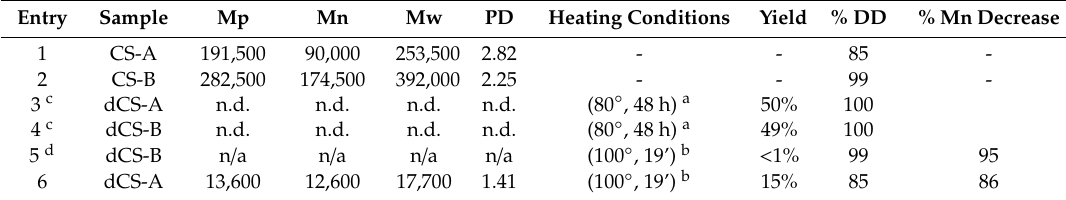
Table 1. Comparison of the average molecular weights of chitosan (CS) and depolymerized chitosan (dCS) measured by gel permeation chromatography